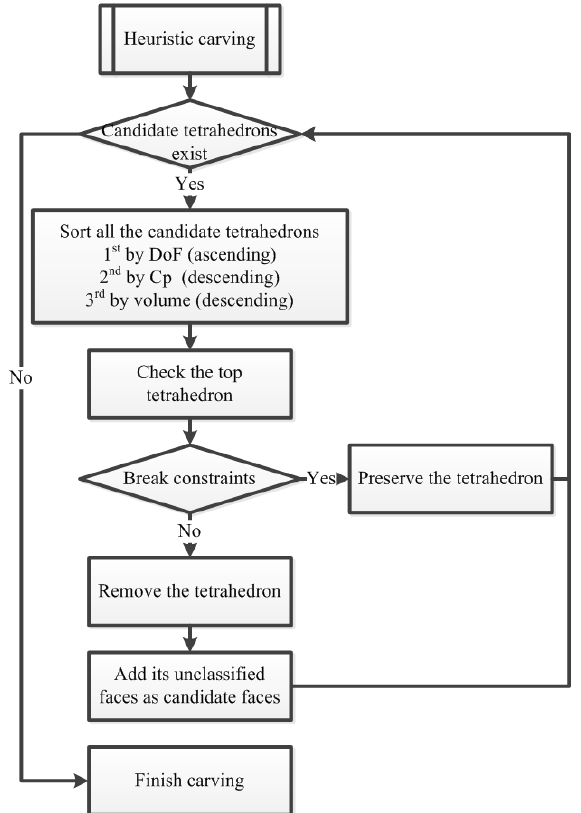
Figure 10. The flow chart of the heuristic carving